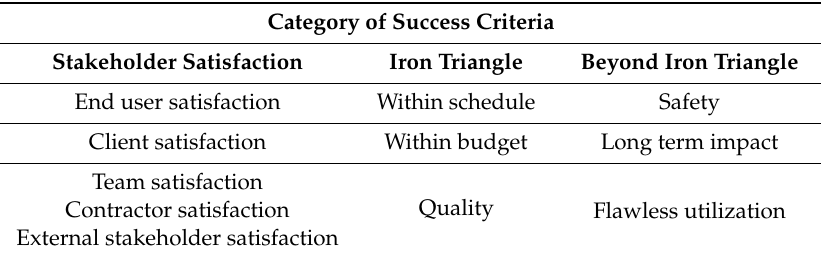
Table A4. Success criteria framework used for this